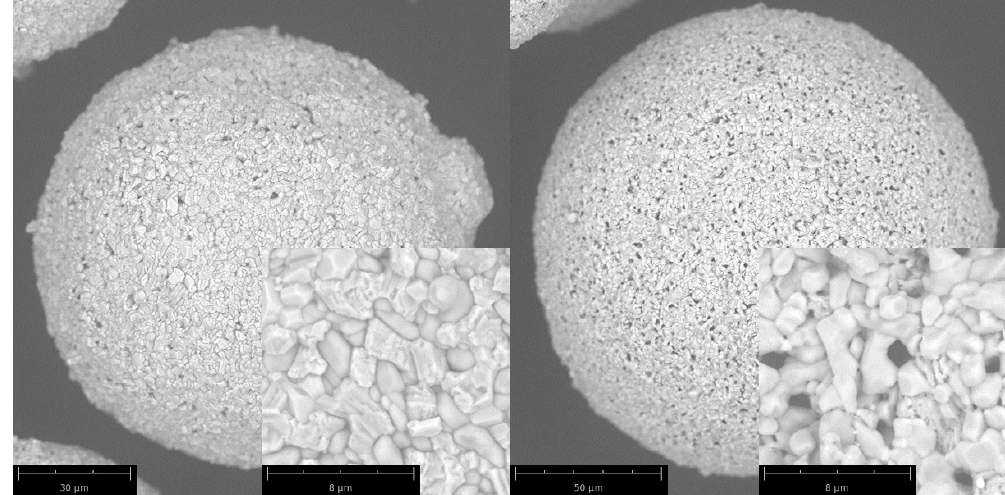
Figure 9. SEM images of M60ST20_1150 in fresh (left) and used (right) states. The main image has a magnification of 2000× and the inset image has a magnification of 10,000×.